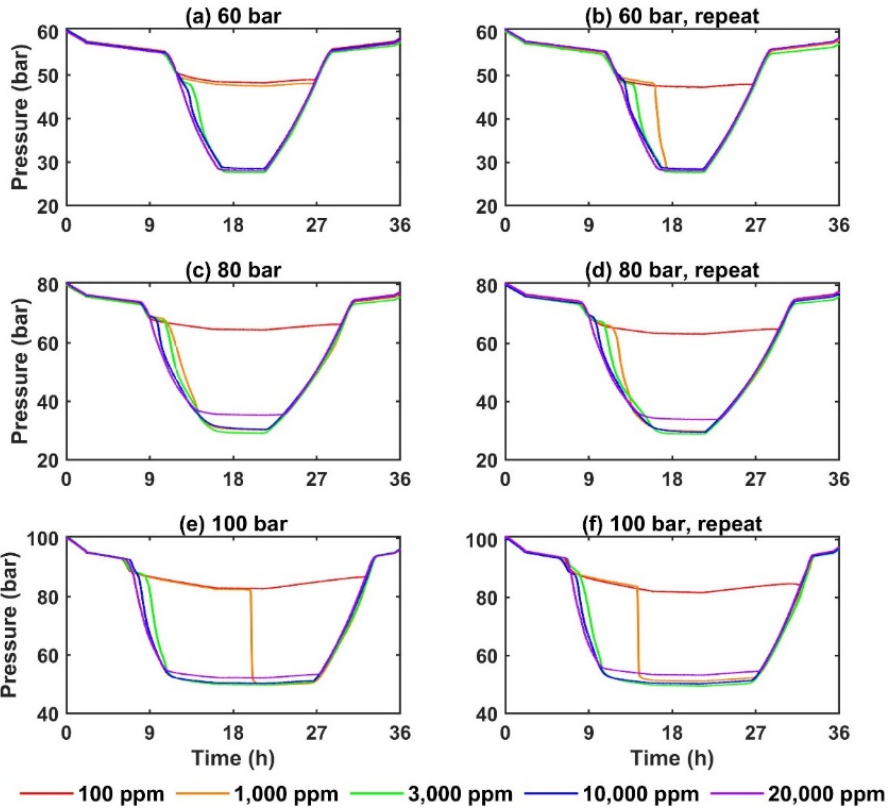
Figure 4. Pressure profiles during the constant ramping temperature scheme in the presence of L- methionine (No memory runs were conducted). Starting temperature 25 ◦ C and final temperature 1 ◦ C. Temperature ramping rate 1 ◦ C/h between 15 ◦ –1 ◦ C. ( a , b ) show two trials at starting pressure 60 bar and ( c , d ) show two trials at starting pressure 80 bar and ( e , f ) show two trials at starting pressure 100 bar.